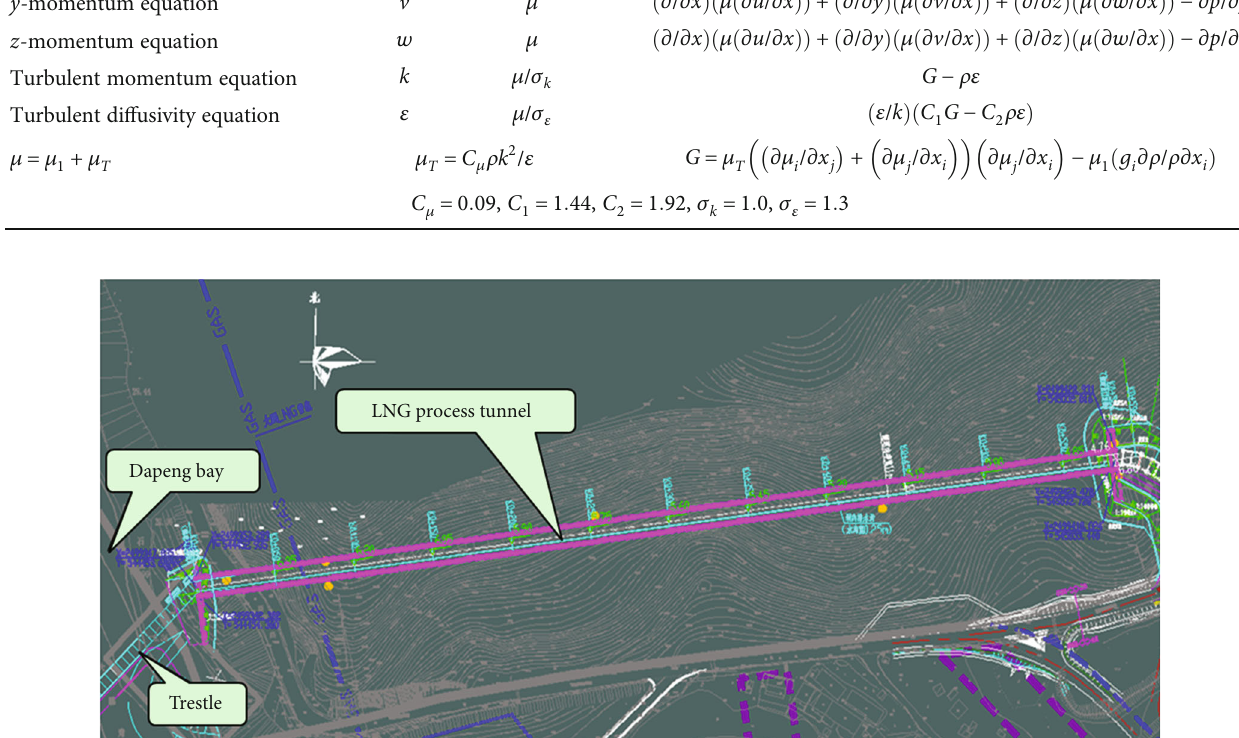
Figure 3: Layout plan of Shenzhen tunnel for an LNG pipeline.